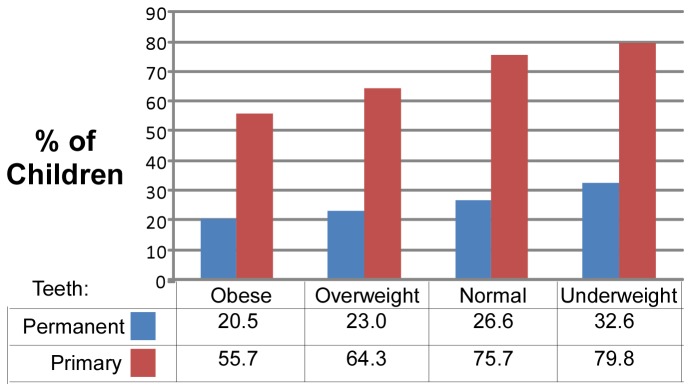
Prevalence of dental decay.The percent of children in each body weight category with at least 1 decayed or filled tooth (computed separately for permanent and primary teeth)..